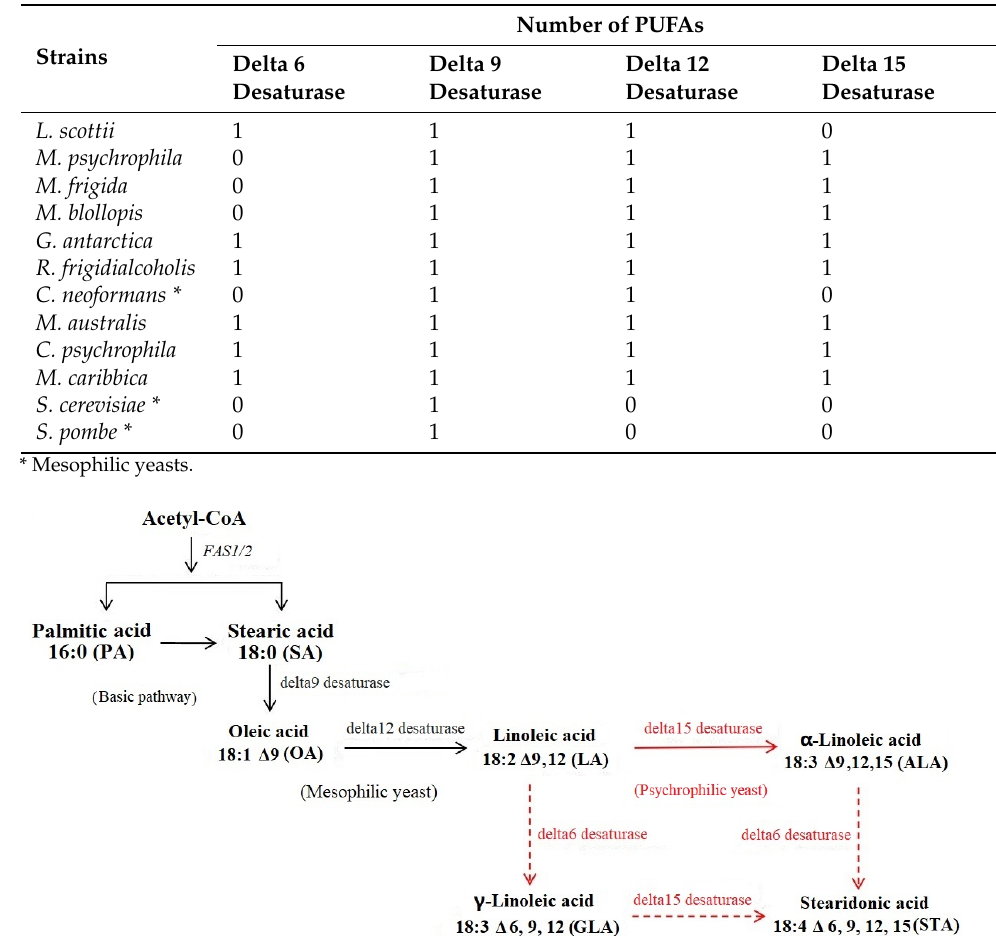
AFPs/ice-structuring proteins can inhibit the growth of ice crystals and improve the freezing resistance of organisms. They have evolved independently in a wide range of organisms, including bacteria, plants, and fish [29]. Despite their independent origins and diverse folding structures, AFPs bind to a common substrate (ice), albeit on different sur- faces and in various orientations. Different anti-cryogenic proteins (AFPs) have different structures, but their surfaces have multiple ice-binding sites, which can be adsorbed onto the ice crystals’ surfaces to inhibit recrystallization and lower the freezing point of the solution, thus helping cells survive at low temperatures [29,30]. An analysis of endemic genes in psychrophilic yeasts revealed that the Antarctic psychrophilic yeast strains G. antarctica PI12 and Leucosporidium spp. have unique AFPs. The phylogenomic analysis of several AFPs in the strain G. antarctica PI12 and AFP genes from other psychrophilic mi- croorganisms revealed that all AFPs can be classified into 15 types, and they showed ob- vious species-specificity within different psychrophilic yeasts (Figure 2). The evolutionary status of AFPs in the strain G. antarctica PI12 is relatively conservative, and they have af- finities with psychrophilic yeasts such as the Leucosporidium genus (Figure 2). For exam- ple, in Group 14 of the AFPs, G. antarctica PI12 and Leucosporidium sp. AY30 clustered in